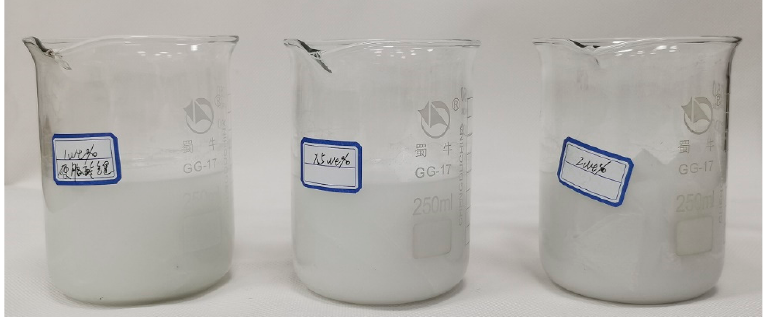
Figure 2. Non-woven fabric being pretreated (The left is the soaking solution with lithium stearate content of 1 wt%, the middle is 1.5 wt% of that, and the right is 2 wt% of that).